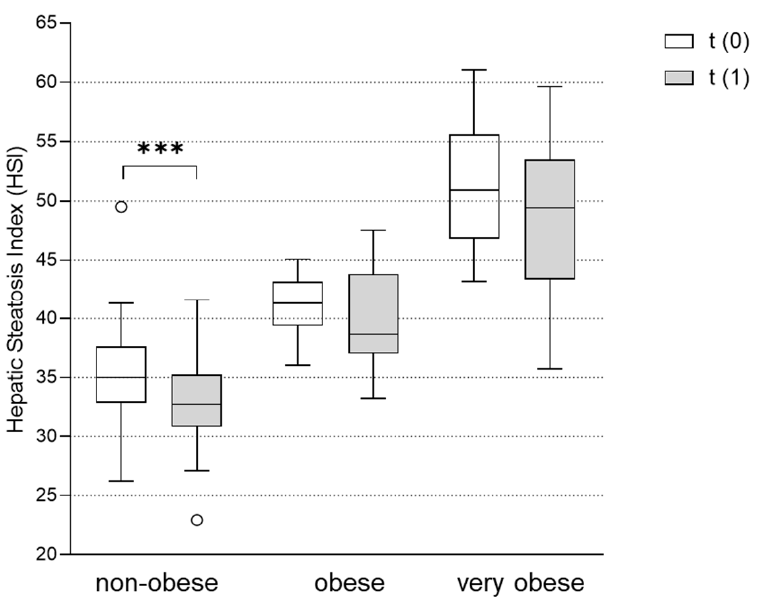
Figure 2. Effect of metformin treatment on body mass index (BMI) in the non-obese, obese and very obese patients. BMI was assessed in subgroups of non-obese (BMI < 30 kg/m 2 ), obese (BMI 30-35 kg/m 2 ) and very obese (BMI > 35 kg/m 2 ) women with PCOS before (t(0)) and after (t(1)) treatment with metformin. Differences between BMI at t(1) vs. t(0) were tested using Wilcoxon tests for paired non-parametric analyses. Data are presented as mean ± standard error of the mean. ** p < 0.01, *** p < 0.001. BMI: body mass index.